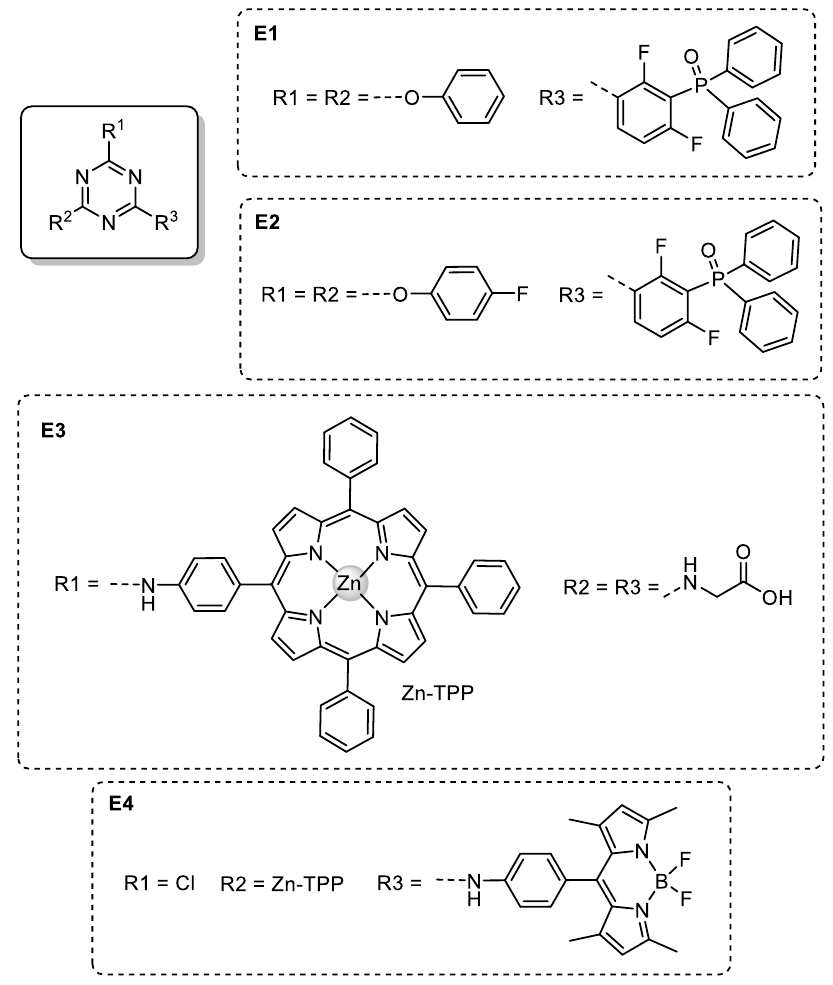
Figure 12. Chemical structures of triazine derivatives used as ILs in PSCs.